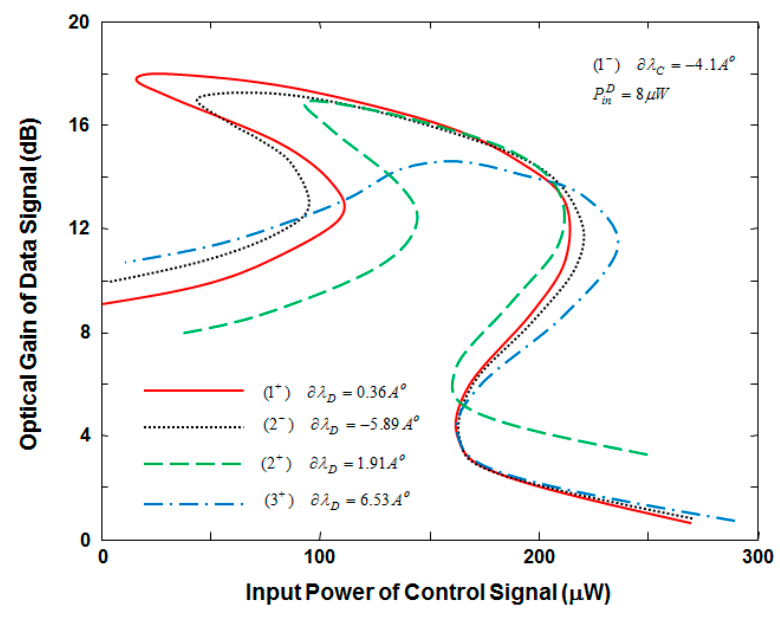
Figure 7. Optical gain of data signal as a function of control-signal input power when the control signal wavelength is fixed and the data-signal wavelength is tuned to different comb